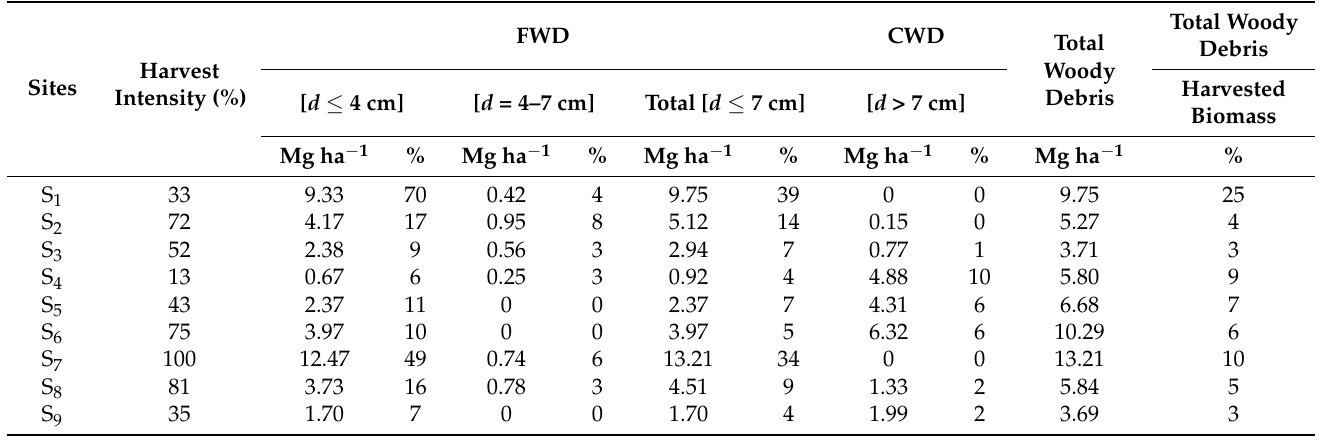
Table 2. Amounts (Mg ha − 1 ) and proportions (%) of woody debris left on sites presented for each wood diameter class.